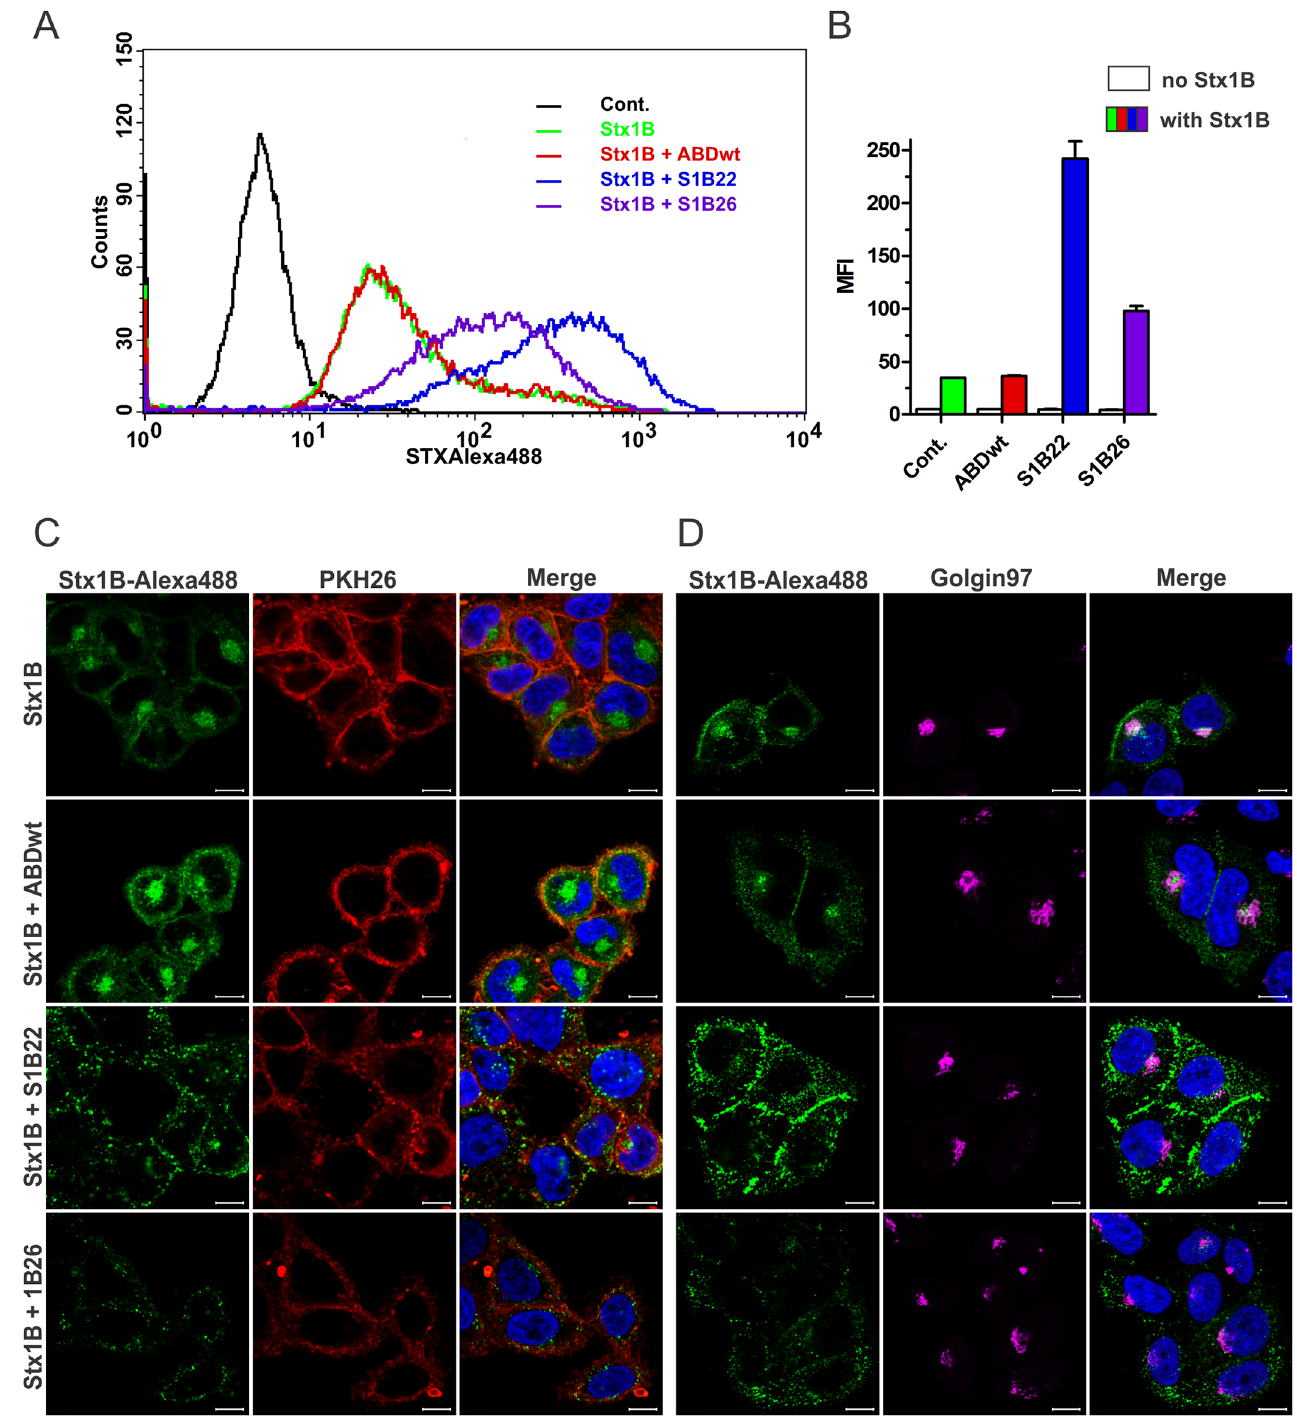
Fig 6. Influence of S1B binders on Stx1B transport into HeLa cells. A, B: Flow cytometric analysis of HeLa cells demonstrating shift in fluorescence intensity (A) and mean fluorescence intensity (MFI; B) upon 1h incubation of HeLa cells with mixtures of S1B22, S1B26 or ABDwt (all in fusion with TolA-Avi and H6) and Alexa Fluor 488-labeled Stx1B. Cont: unstained HeLa cells. Stx1B: HeLa cells incubated with Stx1B-Alexa Fluor 488 alone. C, D: Fluorescence microscopy images of HeLa cells incubated with Alexa Fluor 488 labelled Stx1B (green) with or without pre- incubation with S1B22 and S1B26. DAPI staining (blue) was used to label nuclei. Cells were stained either with PKH26 membrane labeling dye (red; C) and Golgi apparatus was detected with mouse monoclonal Golgin-97 antibody and secondary polyclonal goat anti-mouse antibody conjugated with Alexa Fluor 633 (purple; D). Bars = 10 μ